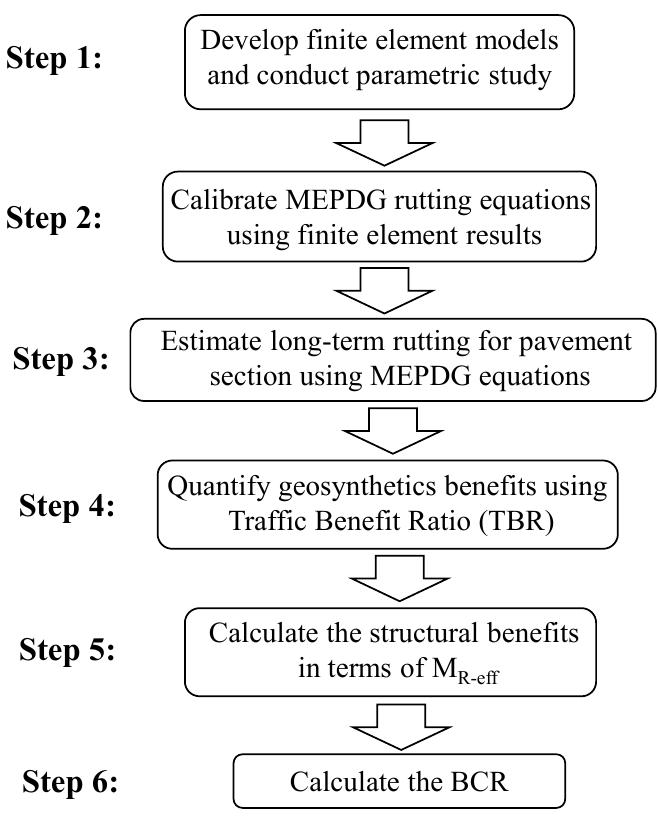
Figure 5. The calculation of structural benefits of the geosynthetics workflow.